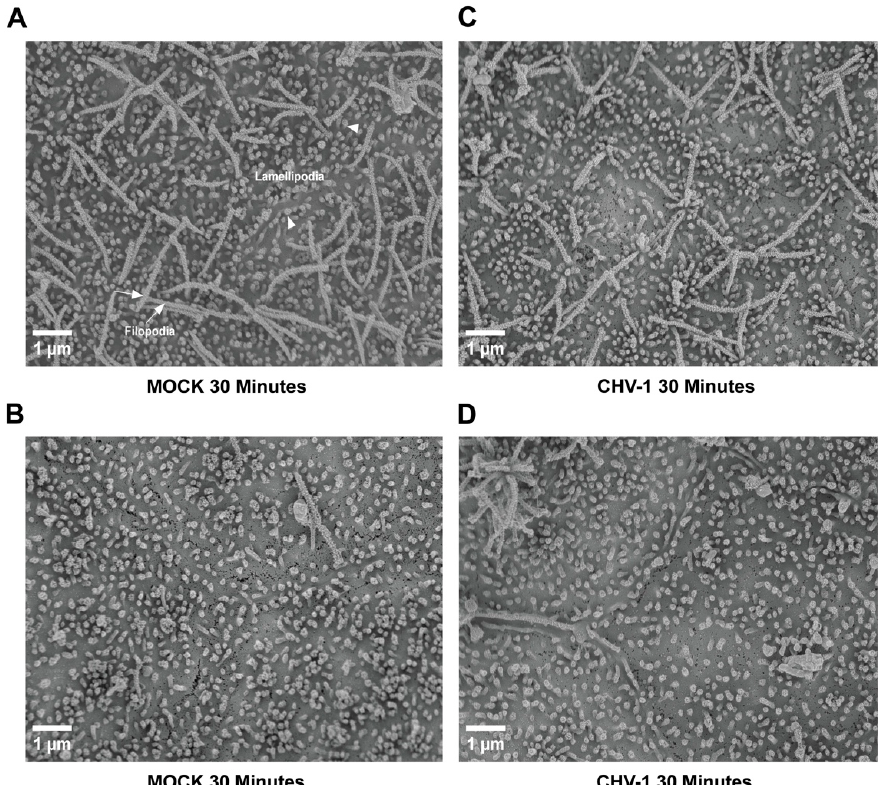
Figure 2. Ultrastructure of the apical surface of polarized MDCK cells is not altered upon CHV-1 entry. Electron micrographs showing the apical surface of MDCK cells polarized on transwell inserts that have either been mock-infected for 30 min (panels ( A , B )) or infected with CHV-1 for 30 min (panels ( C , D )). For each condition, two different sections of the cell surface are shown to illustrate the heterogeneity across the surface of the same cell. Magnification was 10,000 × . Arrowheads point to examples of lamellipodia. Arrows point to examples of filopodia. Results shown are representative images from one of two independent experiments.